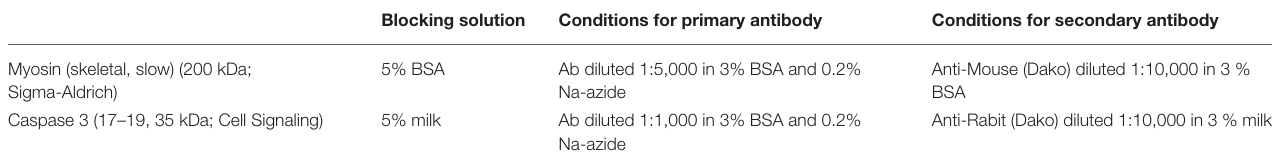
TABLE 2 | Antibody conditions. Blocking solution Conditions for primary antibody Conditions for secondary